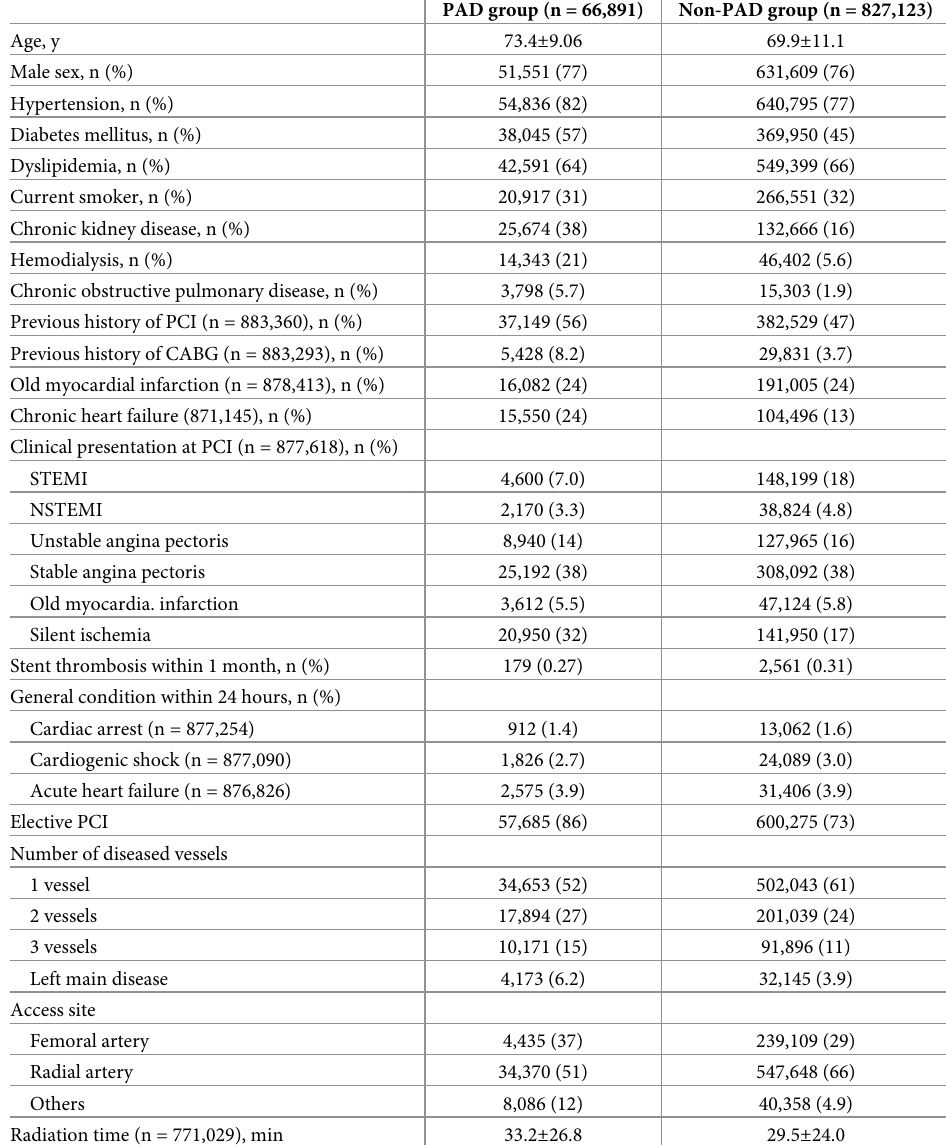
Table 1. Patient